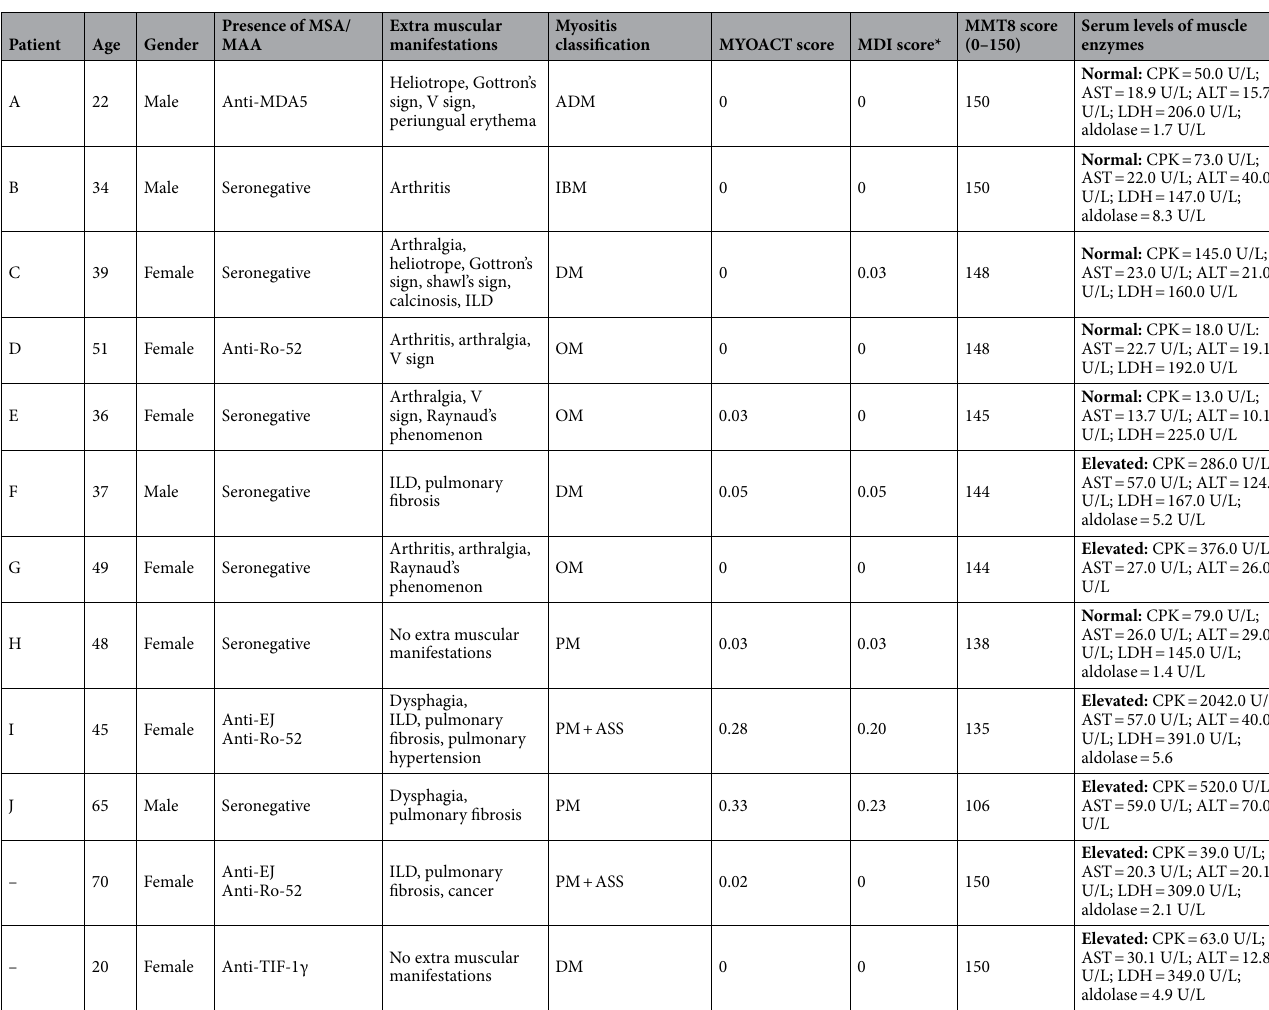
Table 2. Clinical features according to MMT8 score decreasing order. MSA Myositis Specific Autoantibodies; MAA Myositis Associated Autoantibodies; MDA5 Melanoma Differentiation Associated-protein 5;